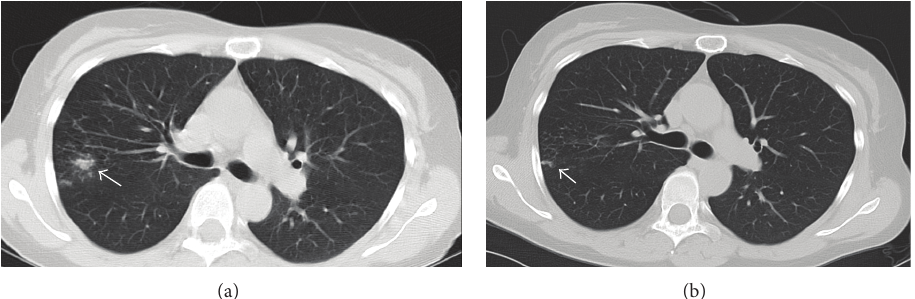
Figure 1: (a) Chest CT scan before starting posaconazole showing reticulonodular opacities in the right upper lobe. (b) CT scan one month after starting posaconazole showing resolution of most of the opacities.